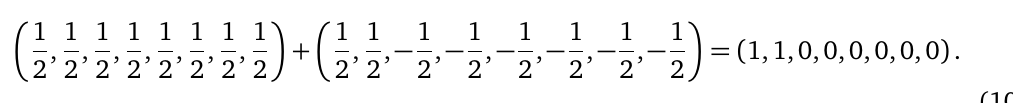
Figure 20: On the lhs the torus with flux ( 2,2,0,0,0,0,0,0 ) . We apply twice the braid relation to obtain the quiver in the middle. Finally by redefining the fugacities we obtain the quiver on the rhs corresponding to flux ( 1,1,1,1,1,1,1,1 ) . Note that the flux